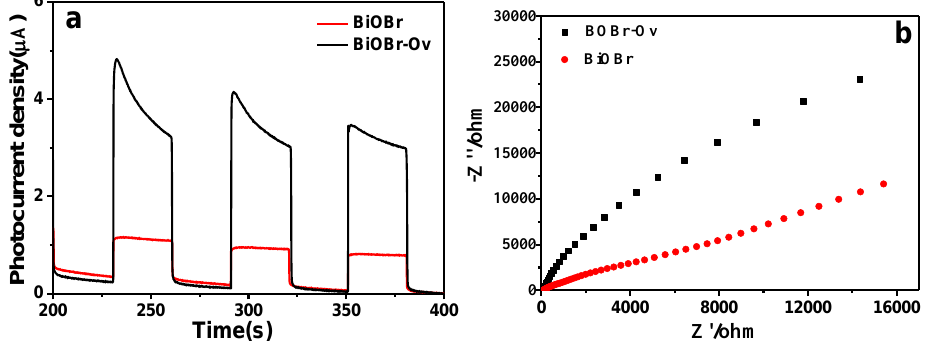
Figure 10. ( a ) Electrochemical impedance spectra and ( b ) photocurrent of BiOBr and